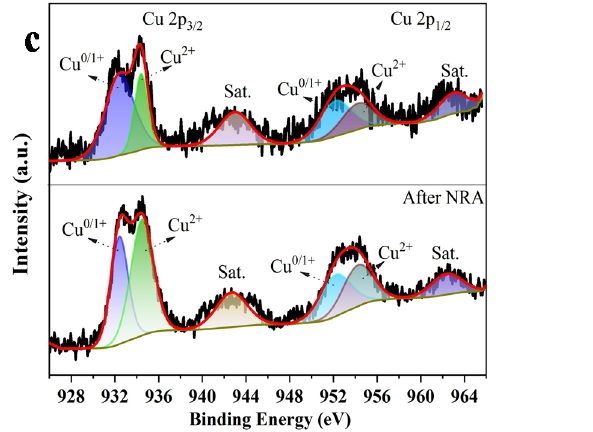
Figure 5. Structure, morphology, and composition analysis after NRA; ( a ) SEM; ( b ) XRD; ( c ) and XPS spectra of CuBMMB; ( d ) proposed electrochemical process involved in the nitrate reduction in CuBMMB.